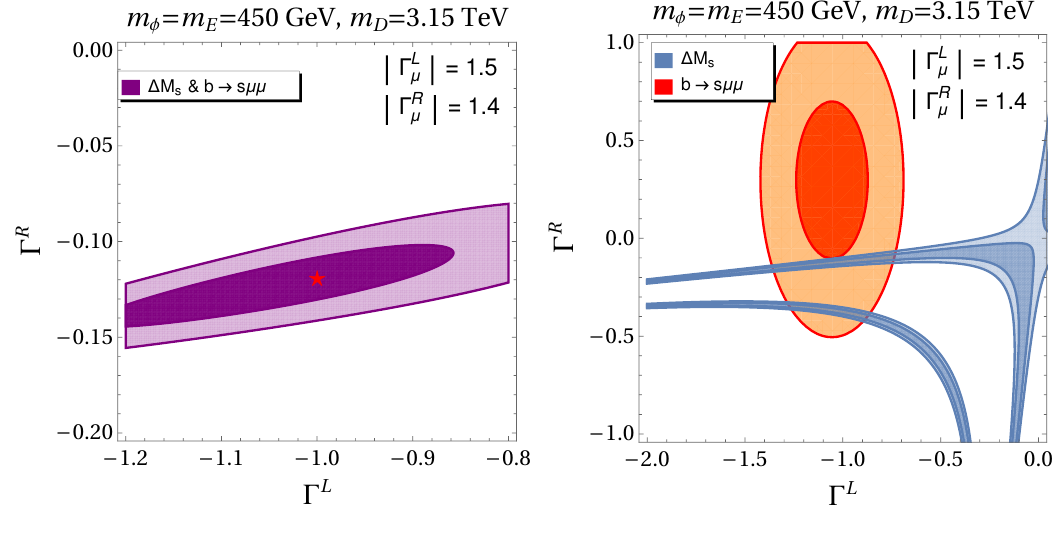
Figure 6 . Left panel: allowed region for the coupling (cid:0) L (cid:17) (cid:0) L mixing and b ! s(cid:22) + (cid:22) (cid:0) data for m (cid:30) = m E = 450 GeV, m D = 3 : 15 TeV, j (cid:0) L The red star marks the values at our benchmark point ( (cid:0) 1 ; (cid:0) 0 : 12). The dark (light) purple regions is preferred at the 1 (cid:27) (2 (cid:27) ) level. Right panel: same as the left panel, but showing separately the allowed regions coming from B s (cid:0) (cid:22) B s mixing (in blue) and b ! s(cid:22) + (cid:22) (cid:0) data (in red). The upper branch allowed by B s (cid:0) (cid:22) B s mixing corresponds to the one shown on the